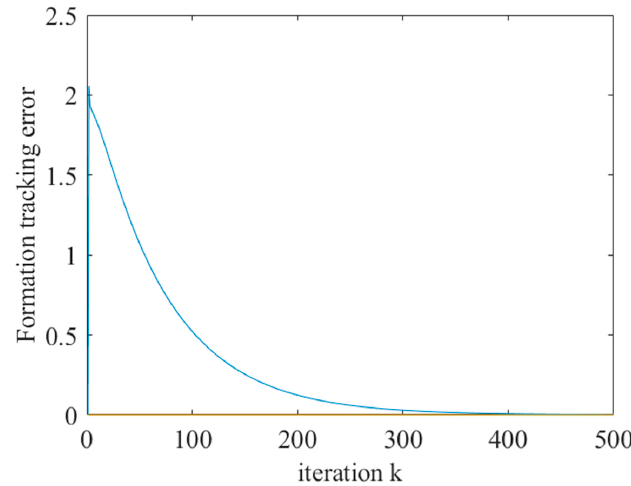
Figure 5. Convergence of formation tracking errors for multi-agent system.